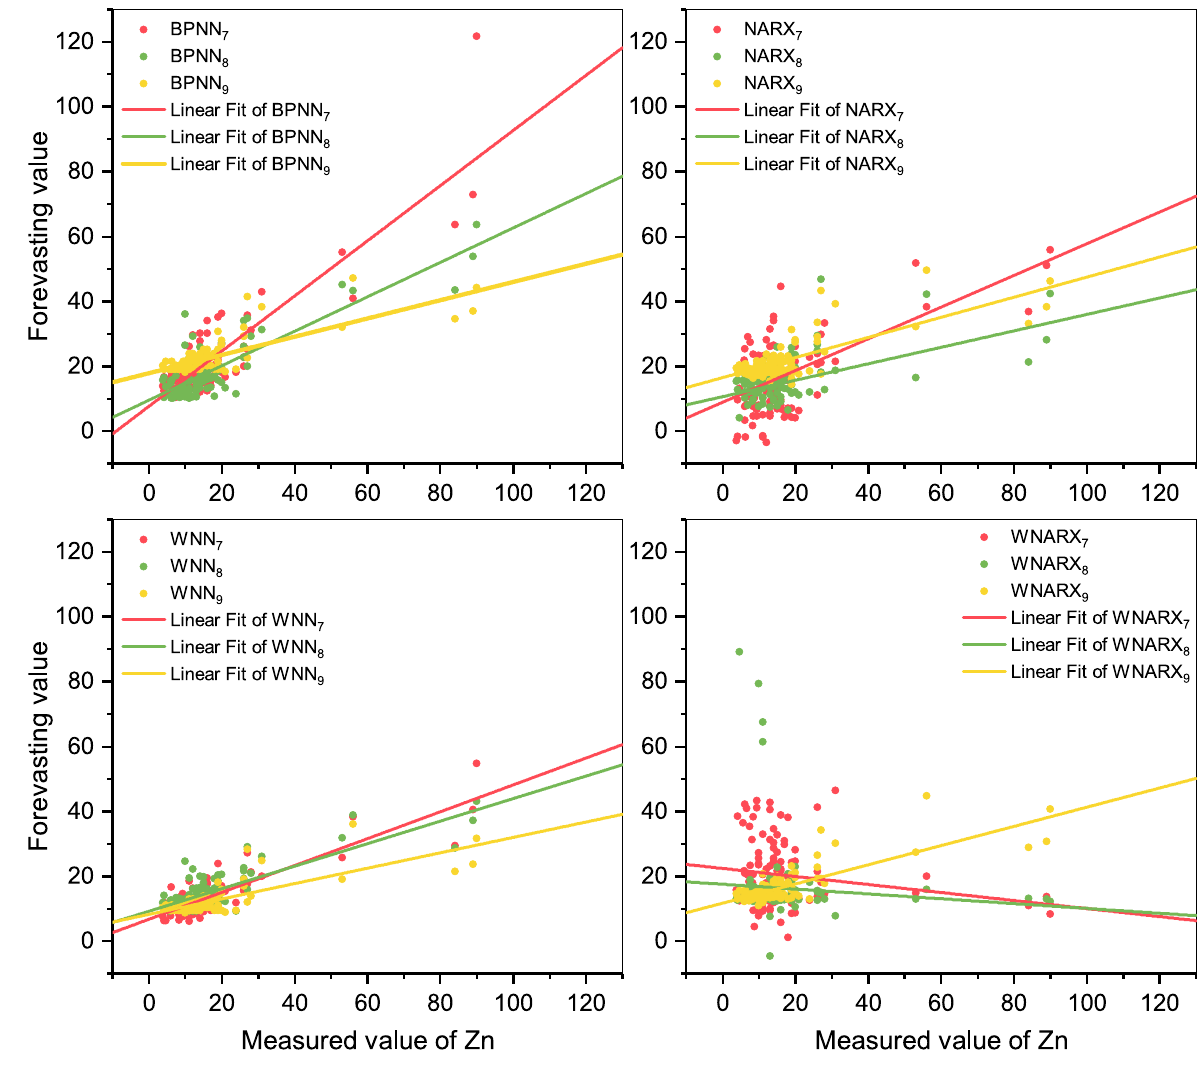
Figure 8. Scatter plots of Zn. The figure shows the scatters distributions under different scenarios for Zn and the linear fit of different scenarios. Meanwhile, the color choice keeps the same as Fig.